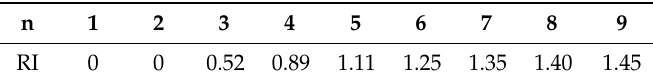
Table 4. Random index (RI) references [64].